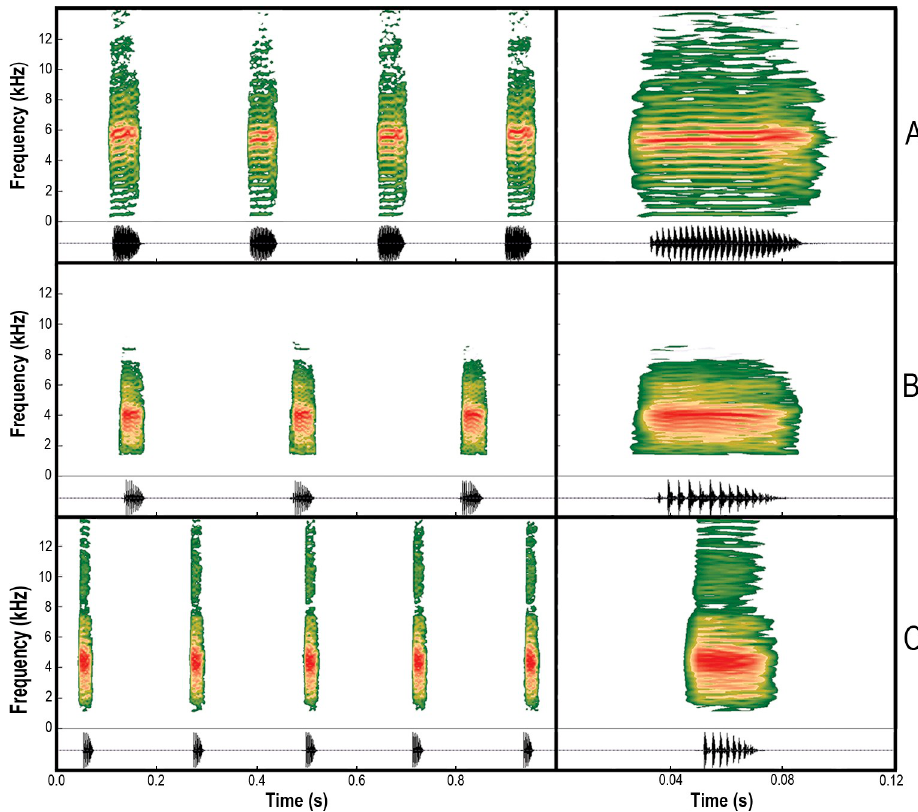
Fig 8. Audiospectrograms (above) and oscillograms (bellow) of the advertisement calls. (A) Scinax fontanarrosai sp. n. (LGE 4451), (B) S . pinima (UFMG 20184), and (C) S . uruguayus (MNHN 9877). Left: A series of calls. Right: A single